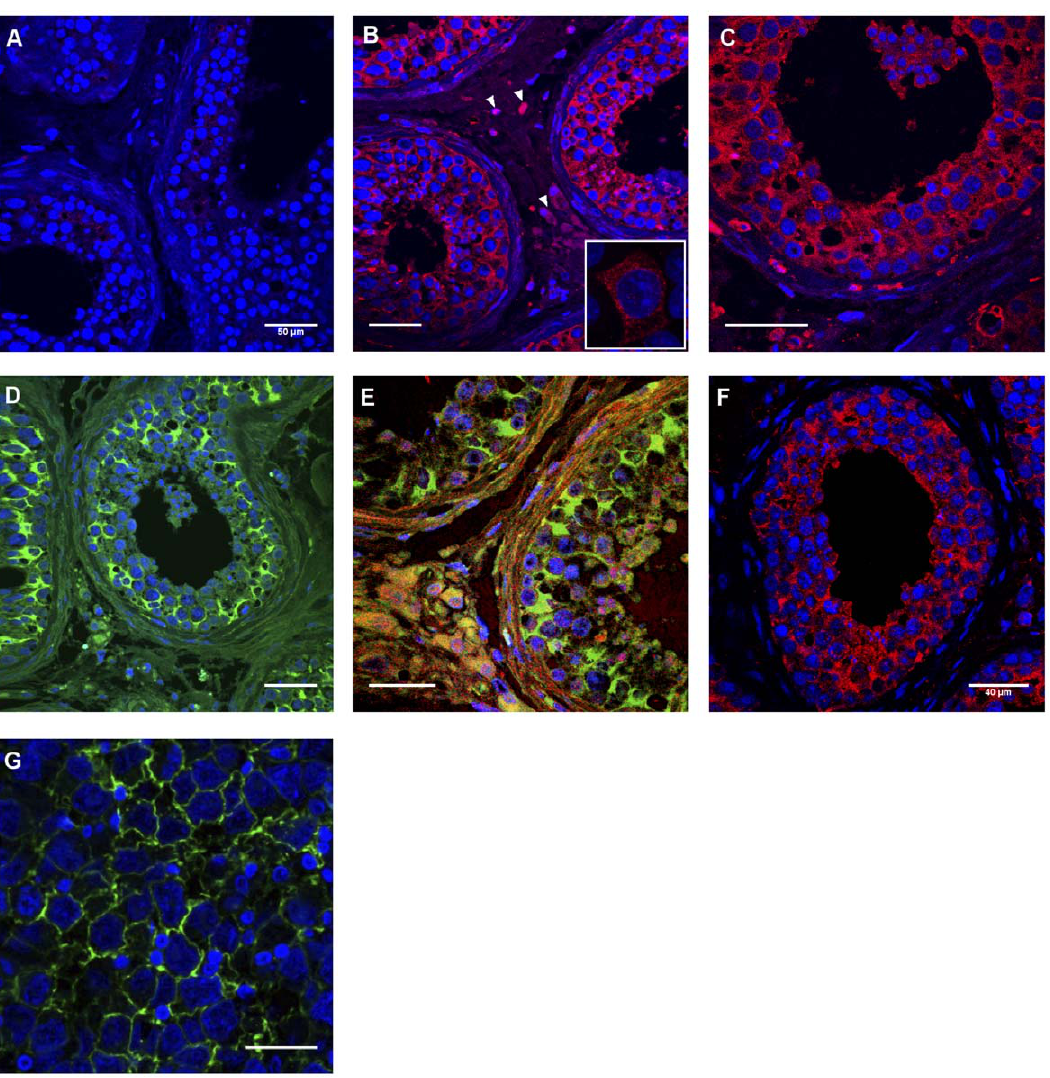
Figure 1. Immunofluorescence analysis of GPER expression in normal human testis and seminoma. GPER was expressed (red fluorescence) in normal testis both in the interstitial compartment (white arrows) and in seminiferous tubules (B, C) as opposed to negative control (A). In order to specifically identify Sertoli cells in seminiferous tubules, a mouse monoclonal anti-vimentin clone V9 Ab (green fluorescence; Dako H Denmark A/S, Glostrup, Denmark) was used (D). Double staining (E) allowed identifying GPER expression both in germinal and Sertoli cells (yellow fluorescence [merge]). GPER was also expressed (red fluorescence) in seminoma cells (F), which were identified on a tumoural section (G) by using a mouse monoclonal antibody against placental alkaline phosphatase (green fluorescence; Thermo Fisher Scientific H , Fremont, CA, USA). In all sections, cell nuclei were stained by Hoechst 33258. Human MCF-7 breast cancer cells have been shown as positive control (window in B). Magnification: 6 40 (A, B, D, E, F); 6 63 (C,